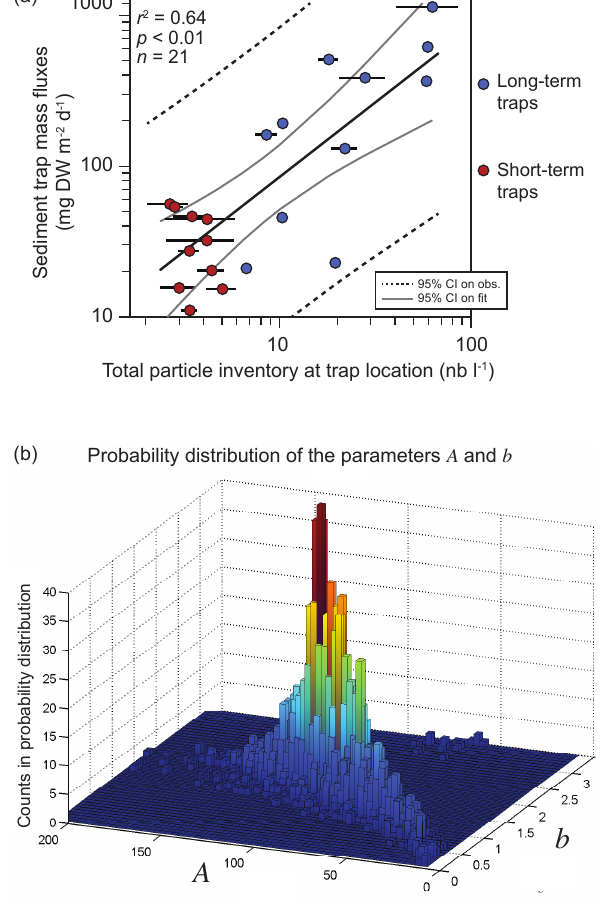
Fig. A1. (a) Relationship between vertical mass fluxes recorded at sediment trap locations against total particle inventory (0.08– 4.2mm ESD) measured with the UVP5 camera deployed at the same locations in July–August 2009. The horizontal bars in panel (a) correspond to the standard deviation of particle abundance as obtained from multiple UVP5 deployments at the trap locations. (b) Result of the multiple random resampling test conducted on the UVP5-sediment trap dataset ( n = 1000; using arbitrarily from 5 to 20 data points each time) in order to document the error around the zone of the most probable parameters A and b (Table 2).